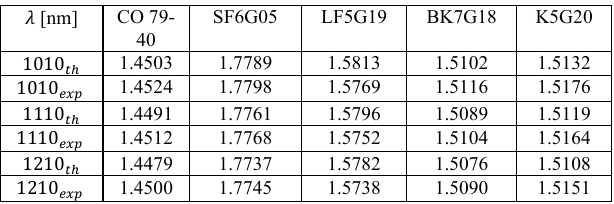
Table 1: Refractive index at room